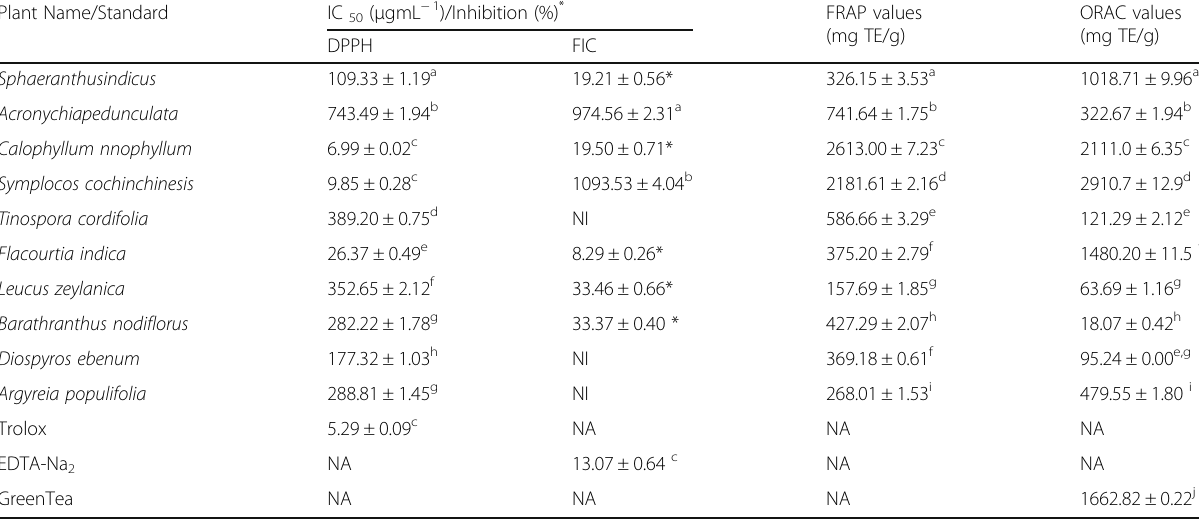
Table 5 Antioxidant activities of ethanol extracts of medicinal plants Plant